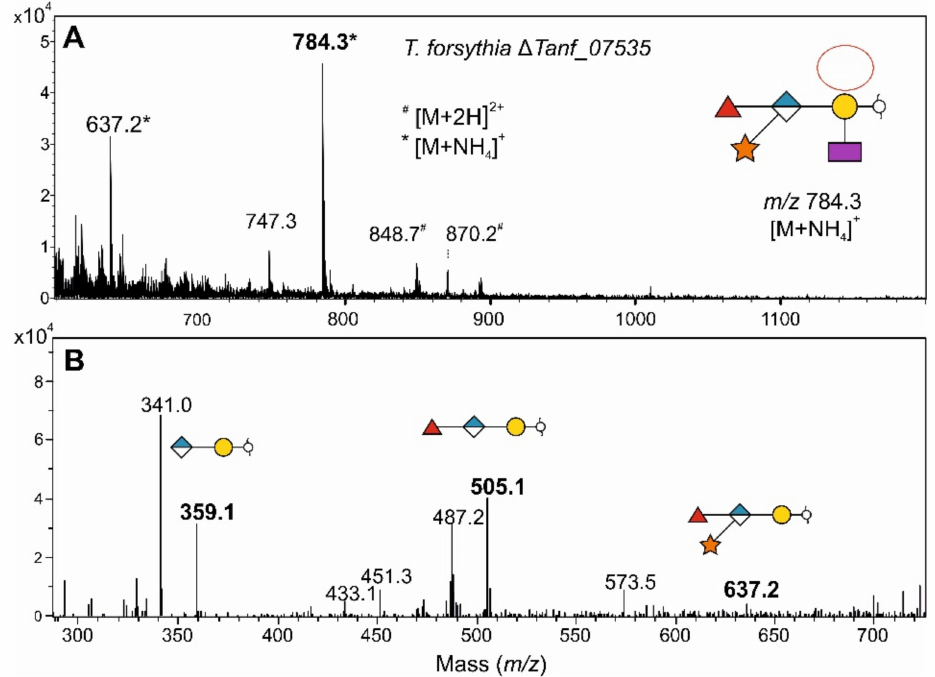
Figure 10. MS analysis of the β -eliminated TfsA O -glycans from T. forsythia ∆ Tanf_07535 ( ∆ fcl ). In the deconvoluted ESI-MS sum spectrum ( A ) of β -eliminated TfsA O -glycans from T. forsythia ∆ Tanf_07535 ( ∆ fcl ), the glycan structure of the signal corresponding to the m / z 784.3 value is drawn according to the symbol nomenclature of glycans SNFG [48]. *, [M + NH 4 ] + ; # , [M + 2H] 2+ . The MS 2 spectrum ( B ) confirms the glycan nature of the m / z 784.3 peak [10]. Peak intensities are provided on the y